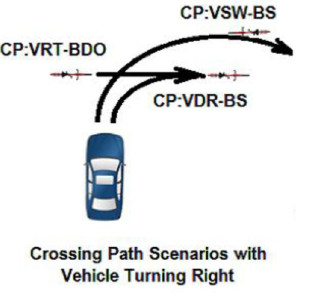
Figure 9 Crash geometry of CP:VRT scenarios